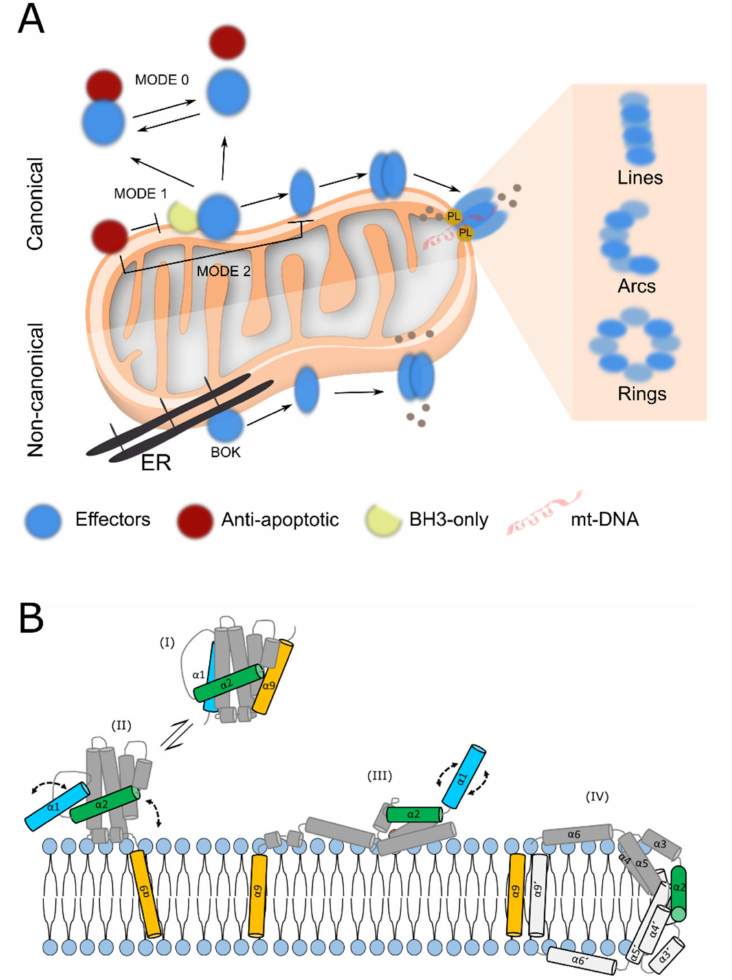
Figure 1. The BCL-2 family of proteins. ( A ) Regulation of apoptosis by the BCL-2 interaction network. Top, canonical BAX / BAK activation. Activation of BAX-type proteins at the mitochondrial outer membrane (MOM) by the BH3 only proteins induces their oligomerization, formation of